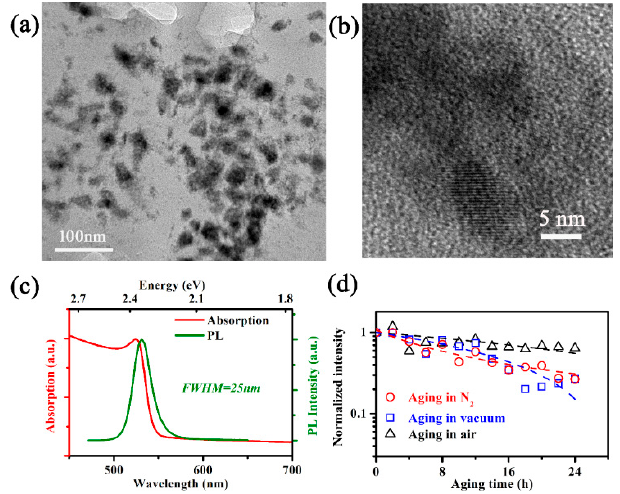
Figure 2. ( a ) A typical TEM image MAPbBr 3 NC in PVDF matrix; ( b ) TEM image of a typical MAPbBr 3 NC; ( c ) normalized absorption and PL spectrum of the fabricated MBNCs-PVDF; and ( d ) PL intensities recorded during aging, normalized to the initial intensity, and presented in logarithmic ordinate. Hollow circles correspond to aging in N 2 , hollow squares to aging in vacuum, and hollow triangles to aging in air, while dashed lines are obtained by linear fitting for aging in vacuum and air and by reciprocal fitting for aging in N 2 . The temperature and 368-nm UV light illumination density during aging are 323 K and 5.6 mW / cm 2 , respectively.